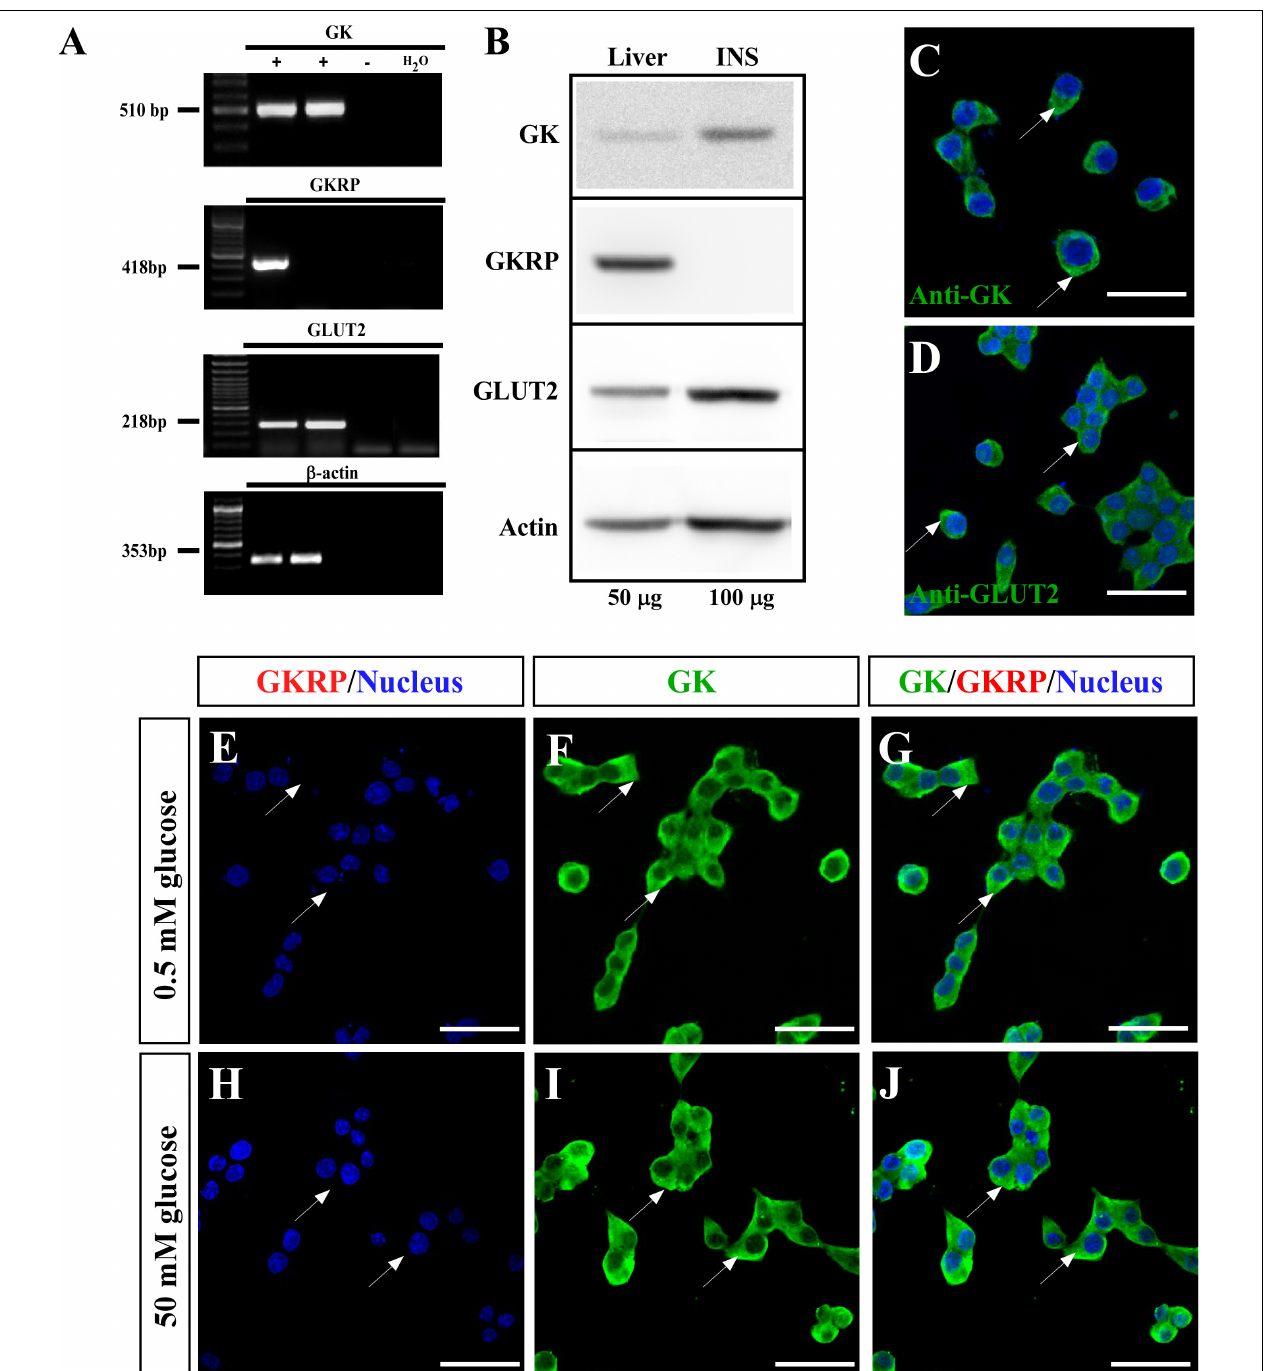
FIGURE 1 | Expression and subcellular localization of glucose sensor machinery in insulinoma cells. (A) RT-PCR for GK (510 bp; first panel), GKRP (418 bp; second panel), GLUT2 (218 bp third panel), and β -actin (353 bp; fourth panel). PCR products were amplified from liver (lane 1), 832/13 culture (lane 2), negative control (RT -) of liver (line 3) and water (lane 4). (B) Western Blot from total protein extracted from liver (lane 1, liver, 50 µ g of protein loaded) and 832/13 culture (lane 2, INS, 100 µ g of protein loaded). Immunodetection was performed for GK (first panel, 52 kDa), GKRP (second panel, 69 kDa), GLUT2 (third panel, 60 Kda), and β -actin (fourth panel, 43 kDa). (C) Immunocytochemistry for GK. (D) Immunocytochemistry for GLUT2. (E–G) Immunocytochemistry for GK and GKRP in insulinoma cultured at 0.5 mM glucose and (H,I) 50 mM glucose. (E,H) Immunostaining for GKRP and nucleus, (F,I) GK, and (G,J) Merge. Nuclear staining performed by Hoechst. Scale bar: 50 µ m. White arrows are indicating the cytoplasm of insulinoma cells.